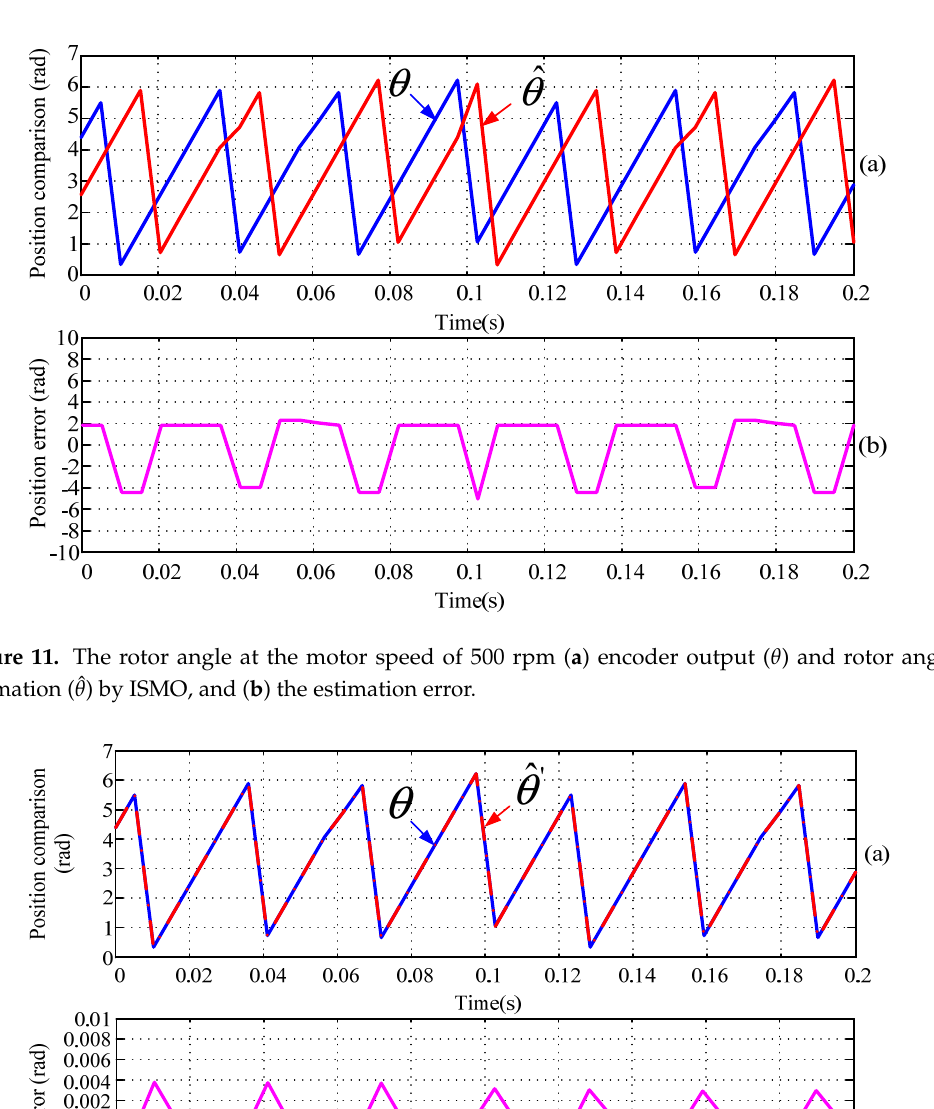
Figure 12. The rotor angle at the motor speed of 500 rpm ( a ) encoder output ( θ ) and rotor angle θ′ ˆ estimation ( ) by NN-ISMO, and ( b ) the estimation error.